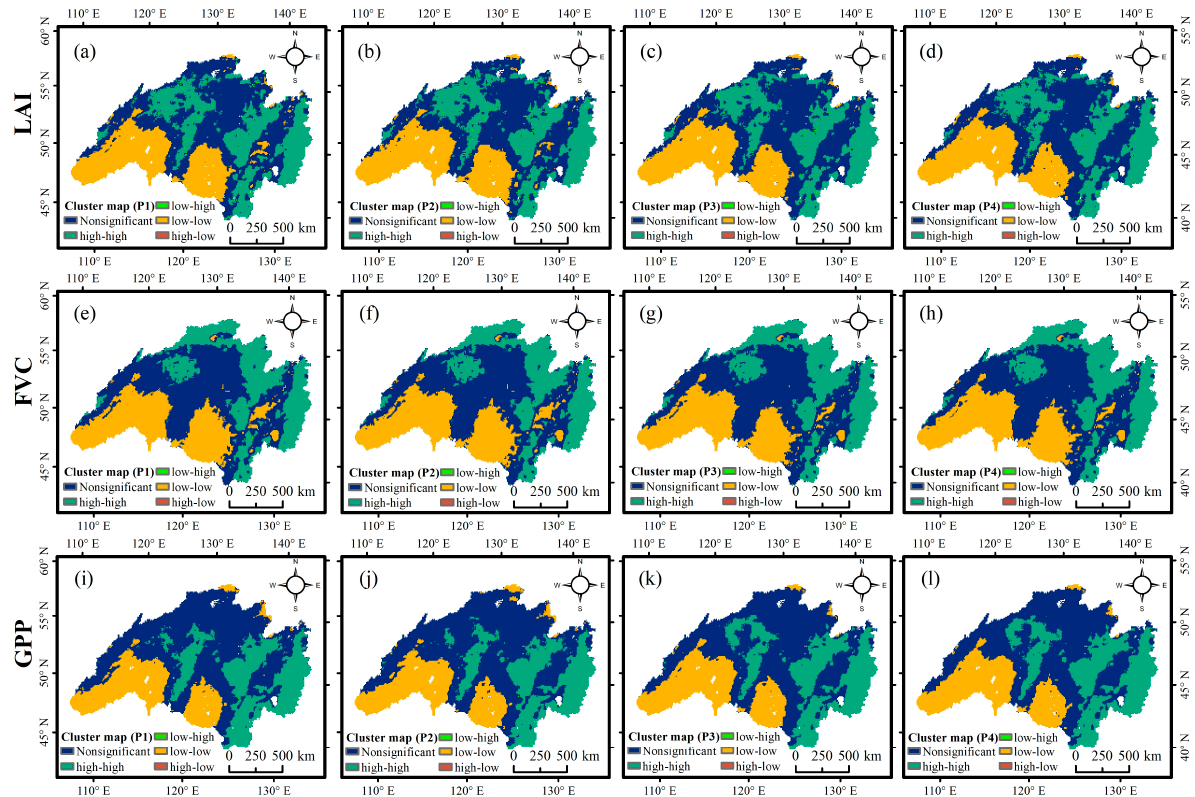
Figure 5. Clustering maps of local Moran’s I of LAI, FVC and GPP in the ARB for four studied periods: ( a – d ) show clustering maps of LAI for Periods 1–4, respectively. ( e – h ) and ( i – l ) are the same as ( a – d ) of four studied periods, but for clustering maps of FVC and GPP, respectively. Figure 5e–h presented the clustering maps of local Moran’s I of FVC in the ARB for four studied periods. The local Moran’s I of FVC for the four periods ranged from − 0.67 to 6.45, − 0.69 to 6.67, 0.57 to 6.21 and − 0.65 to 6.63, respectively. Like the LAI spatial autocorrelation, the local spatial autocorrelations of FVC for the four periods were